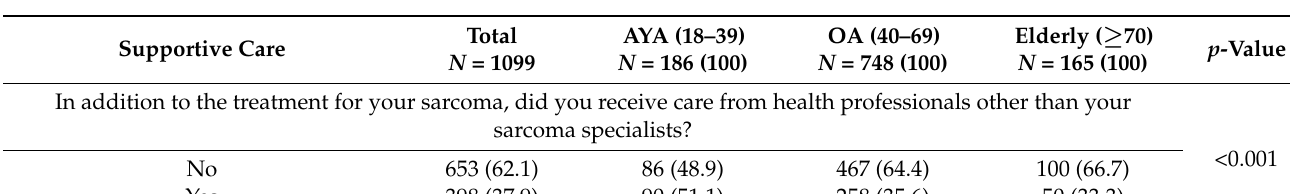
Table 5. Supportive care in rare cancer